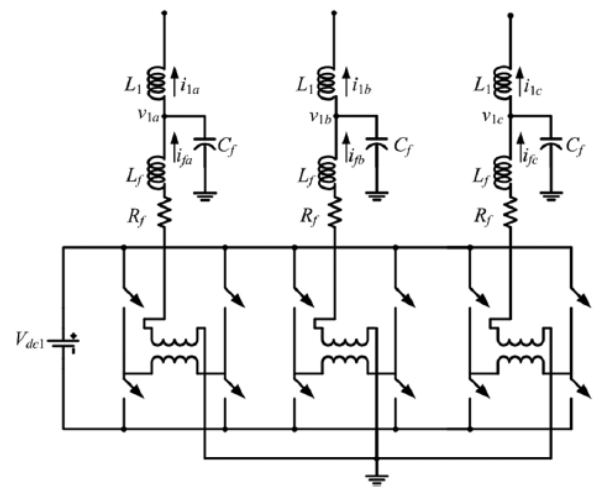
Figure 2. A schematic diagram of Voltage Source Converter (VSC) structure [28].